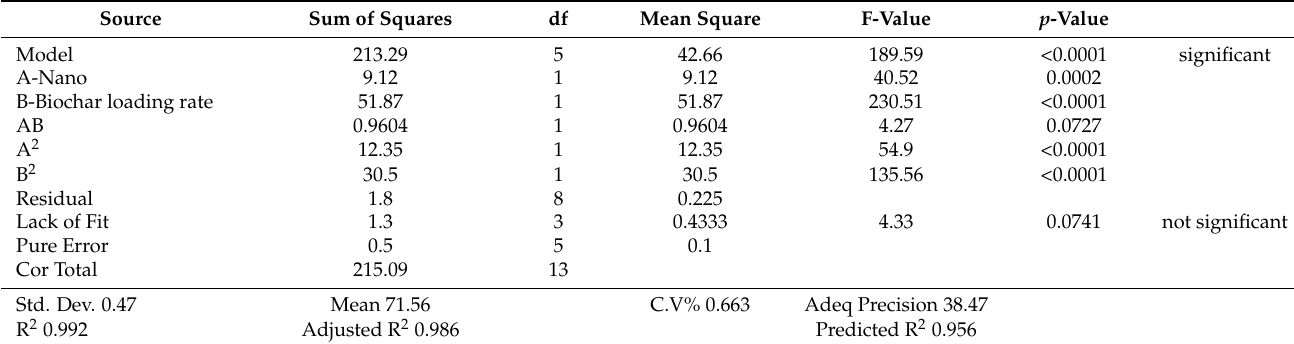
Table 4. Analysis of variance in COD reduction